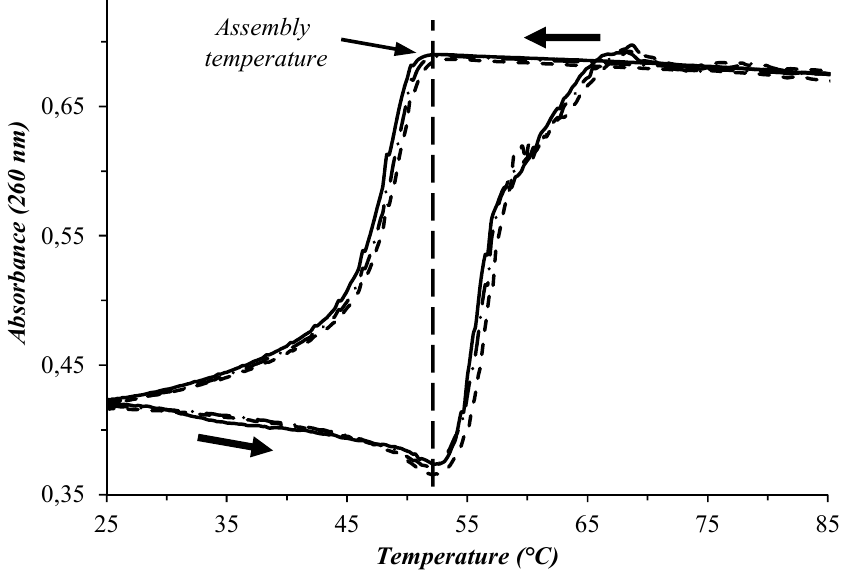
Figure 2. Absorbance at 260 nm as a function of temperature of a solution of AuNP-DNAA mixed with AuNP-DNAT . Three assembly/disassembly cycles are 11